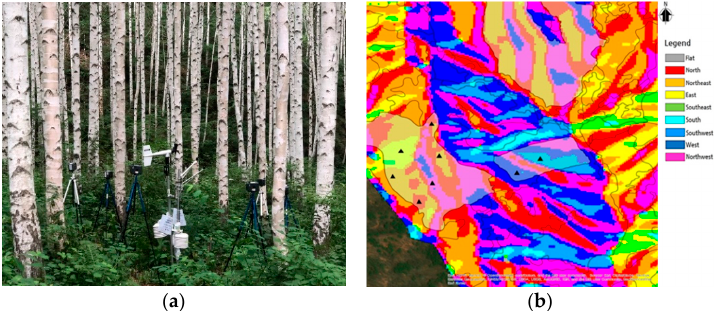
Figure 1. General current status of the research designated area. ( a ) Placing measurement devices on the site. ( b ) The classification map of site types.